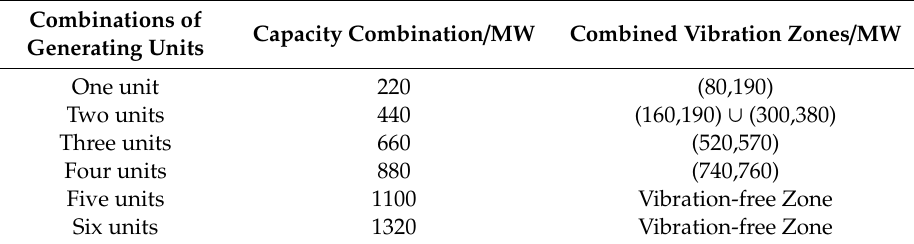
Table 7. UC combined vibration zones of TSQII (Water head 170 m).